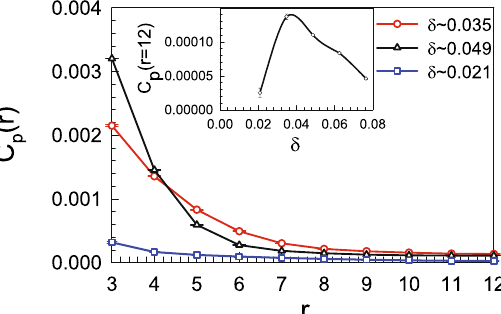
Figure 8. The p -wave superconducting pairing correlation as a function of the distance r on a lattice with 2 × 6 × 24 sites. Inset: the doping-dependent pairing correlation at r =